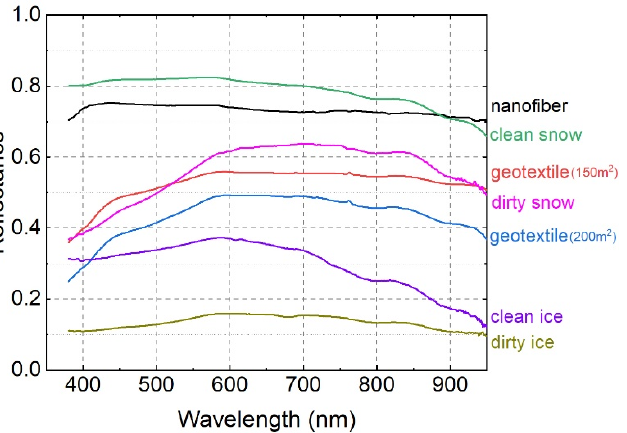
Figure 8. Spectral reflectance of materials and surrounding snow and ice surfaces. The situations of the observation surface are shown in Figure 9.